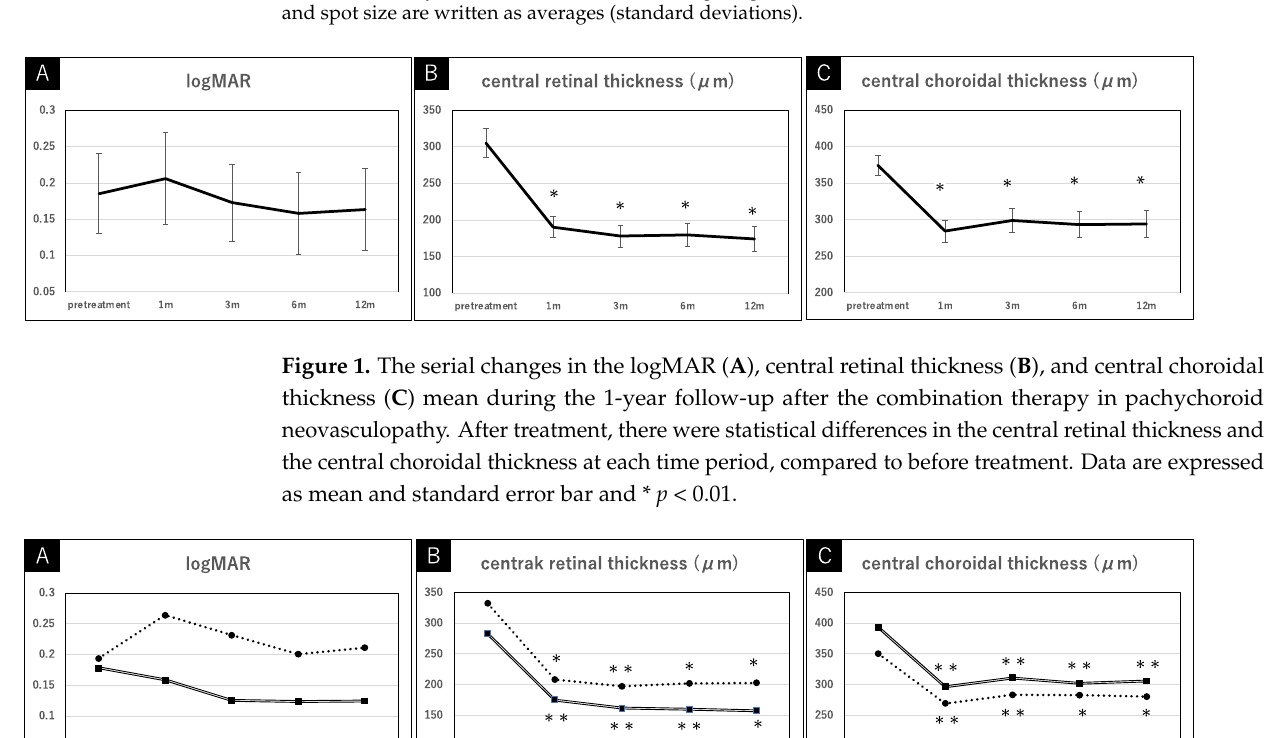
the 1-year follow-up after the combination therapy, divided into the full or reduced treat- ments, are shown in Figures 1 and 2.